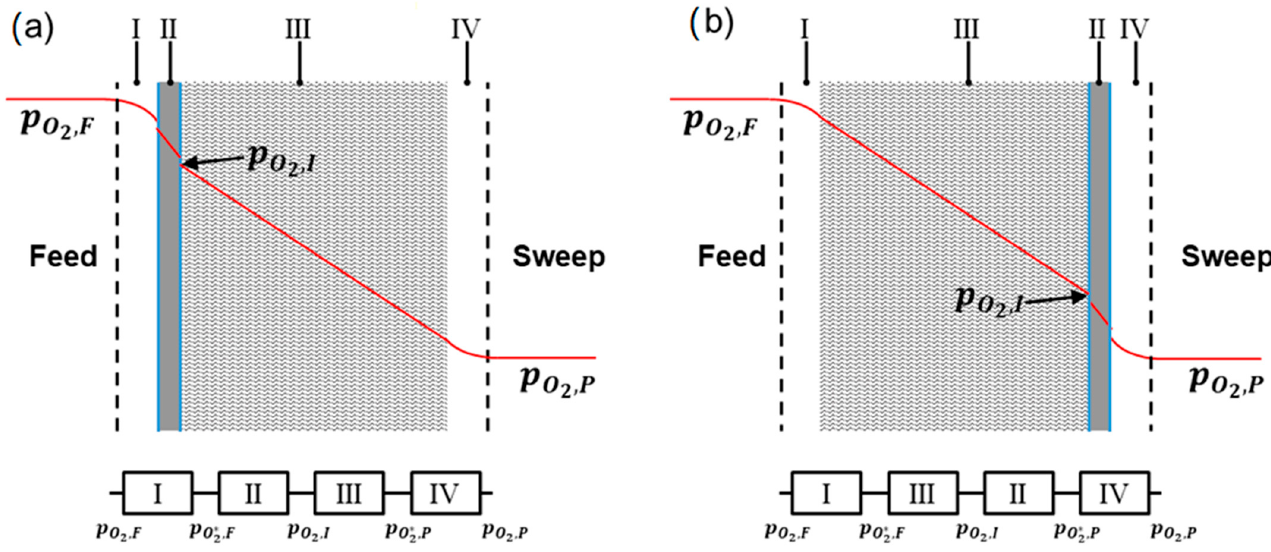
Figure 1. Partial pressure of O 2 (red line) in a cross section of an asymmetric membrane; ( a ) membrane operated with support on the permeate side (SP); ( b ) membrane operated with support on the feed side (SF); the flow resistance can also be expressed as linear connection of resistors. (adapted from [15]).